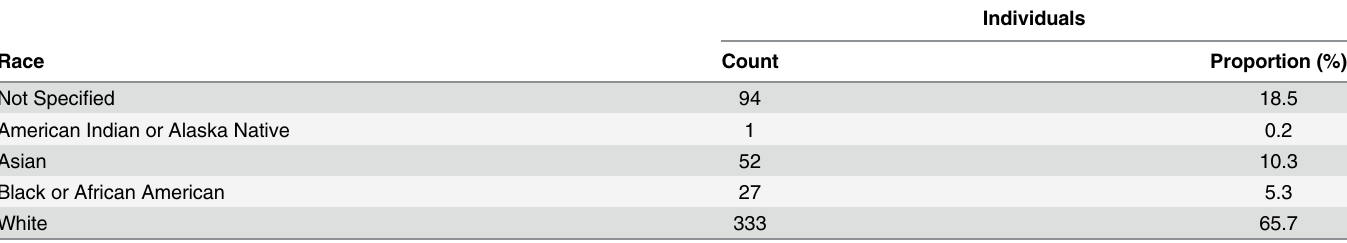
Table 4. Race distribution of 507 Thyroid Carcinoma Samples (THCA) from The Cancer Genome Atlas (09/21/15) (http://cancergenome.nih.gov/).